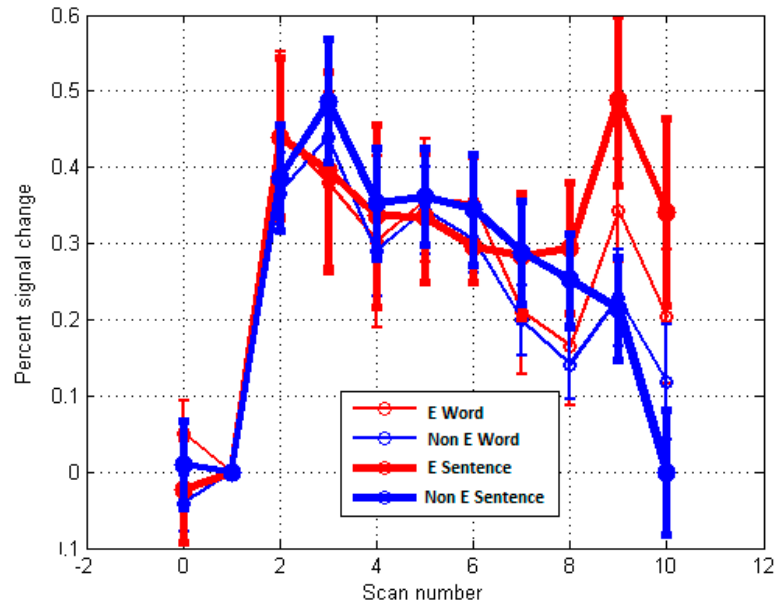
Figure 7. MR time-course during localizer activity averaged across participants for Sentences versus Word overall activation. ( p < 0.05) for Emotion / Feeling-Action PO—ROI analysis (n = 17 E group versus n = 23 Non E group) for Brodmann area 9 (right hemisphere) where p = 0.032, F (1.38) = 4.955 for Scans 9 and 10. Table 3. PO ROI Time course analysis: significant PO trait group e ff ects—ROI (Higher